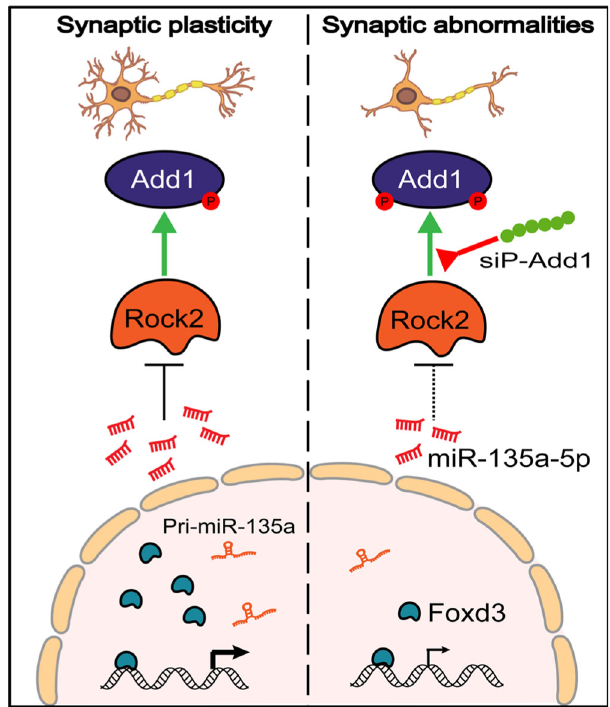
Fig. 8 miR-135a-5p/Rock2/Add1 signal mediates the synaptic/memory impairments in AD. In normal conditions (left), miR-135a-5p was transcriptionally regulated by Foxd3 and suppressed the Rock2 expression, which was essential for normal synaptic plasticity. In AD (right), loss of Foxd3 results in the downregulation of miR-135a-5p and the overexpression of Rock2, which in turn caused the hyperphosphorylation of Add1 in the Ser726 site and the aberrant dendritic morphology, as well as the synaptic/ memory impairments. Blocking the hyperphosphorylation of Add1 by siP- Add1 partially rescued those